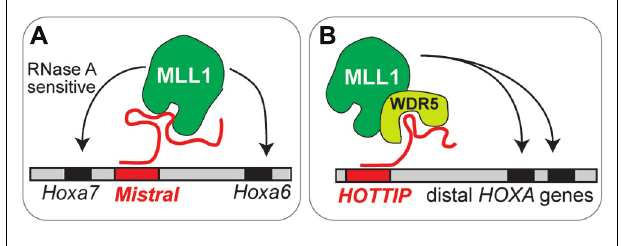
FIGURE 2 | Emerging models of lncRNA function in chromatin- modifying complexes. (A) Mistral recruits MLL1 to specific Hox genes. This MLL1 binding is sensitive to RNase A, which degrades single stranded RNA. (B) HOTTIP recruits MLL1 through interaction withWRD5, a core component of MLL